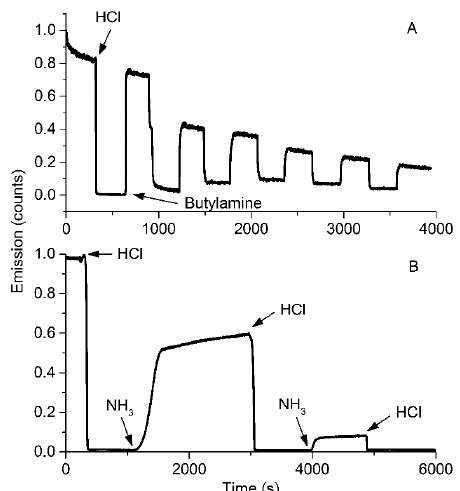
Figure 7. Kinetic response of the MMPyP/TiO 2 composite to saturated vapours of ( A ) butylamine and ( B ) ammonia. Arrows indicate the beginning of the exposure to the indicated gas.